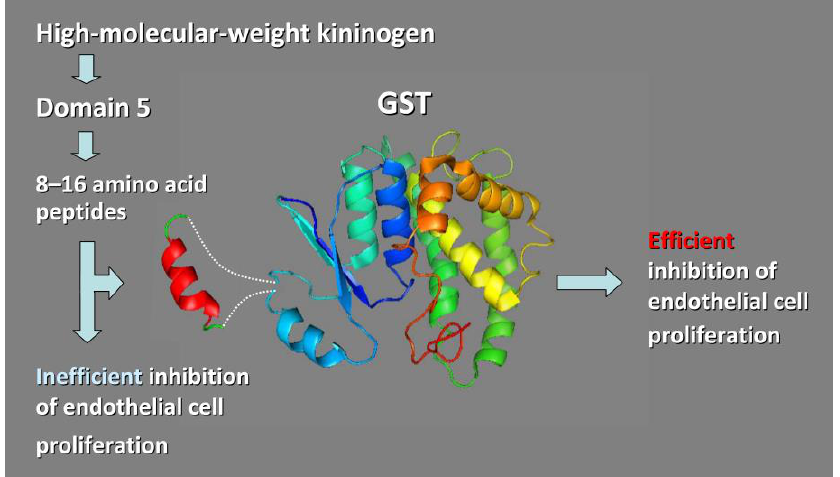
Figure 4. Grafting of short human high molecular weight kininogen (HK) peptides onto Glutathione S- Transferase (GST) backbone enhances HK peptide’s ability to inhibit endothelial cell proliferation [46]. GST on its own does not inhibit cell proliferation.